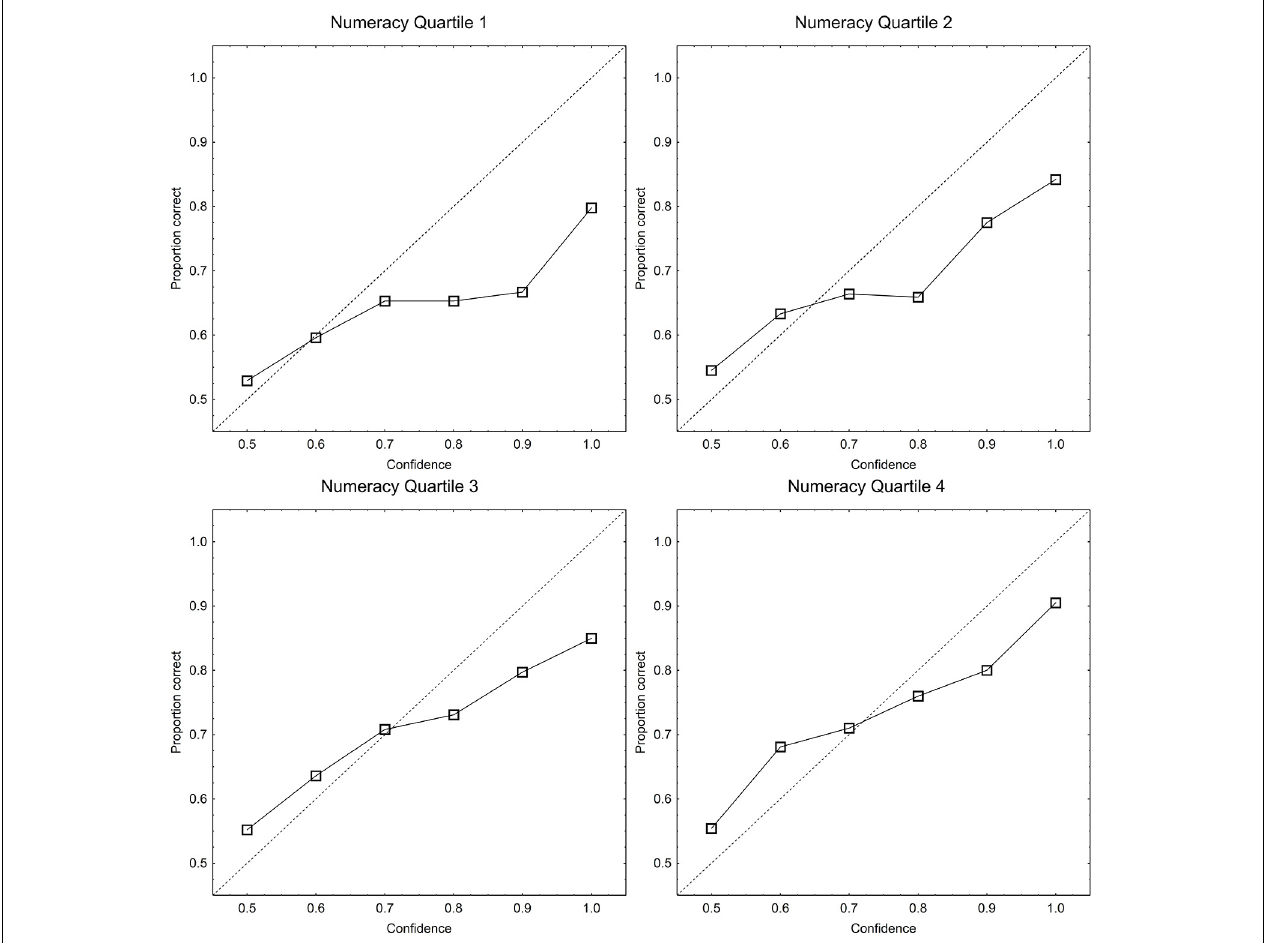
FIGURE 2 | Proportion correct plotted as function of confidence category (calibration curves) for the single statements in each of the numeracy quartiles. The dotted identity line is perfect